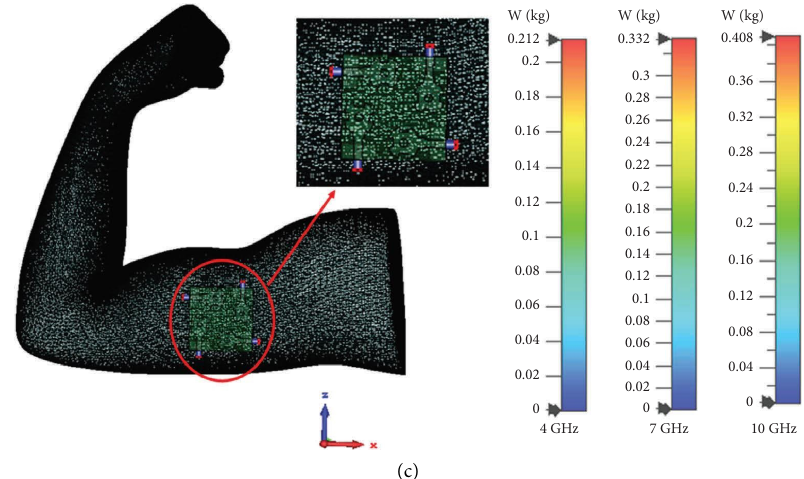
Figure 20: SAR values obtained from the open-source model: (a) chest, (b) thigh, and (c) arm.